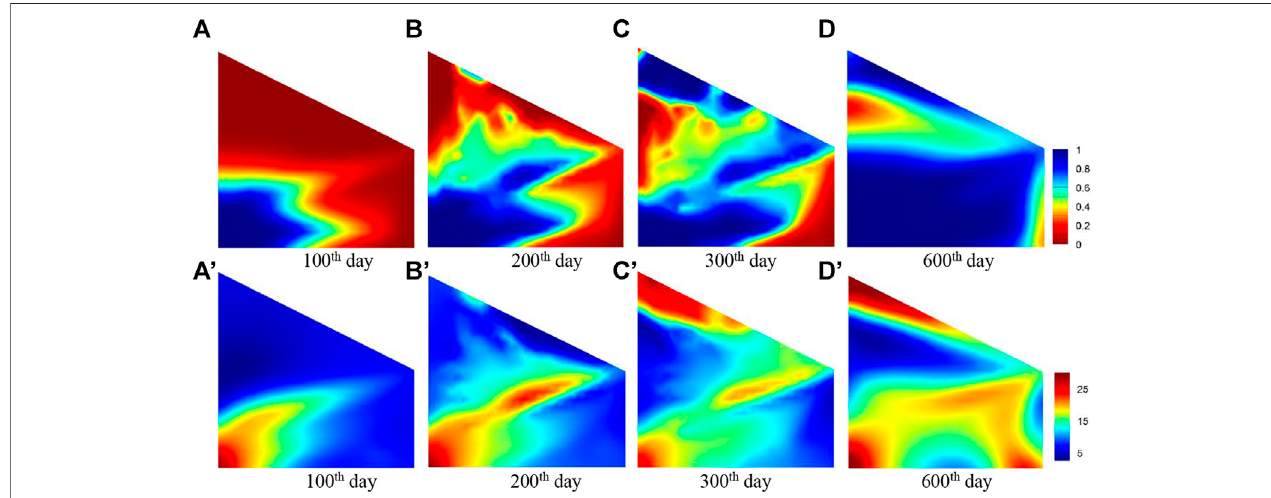
FIGURE 12 | The ferro fl uid saturation and magnetic anomaly distribution at different time. (A – D) respectively show the ferro fl uid saturation at 100th, 200th, 300th, 600th day; (A 9 – D 9 ) respectively show the magnetic anomaly at 100th, 200th, 300th, 600th day.